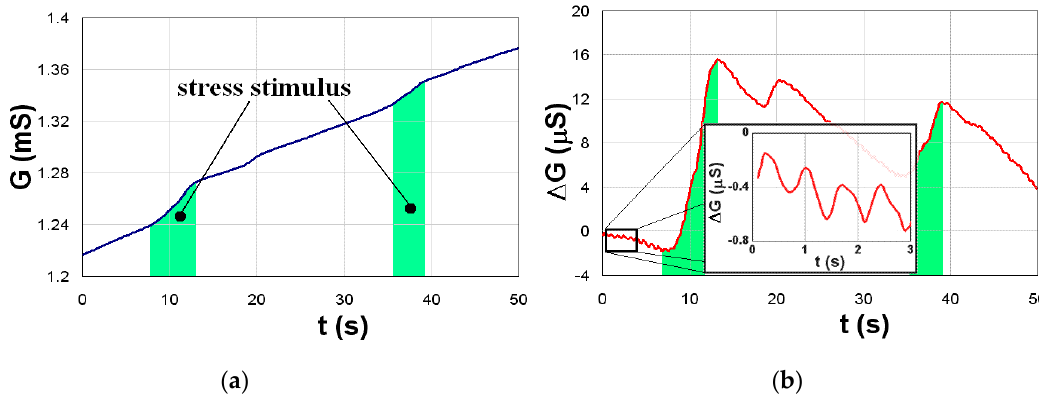
Figure 9. Typical time responses of EDA: ( a ) Original signal, ( b ) filtered signal with visible heart- pulses.